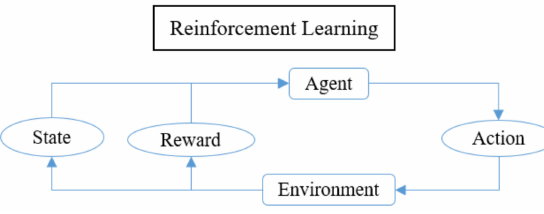
Figure 1. Scheme of reinforcement